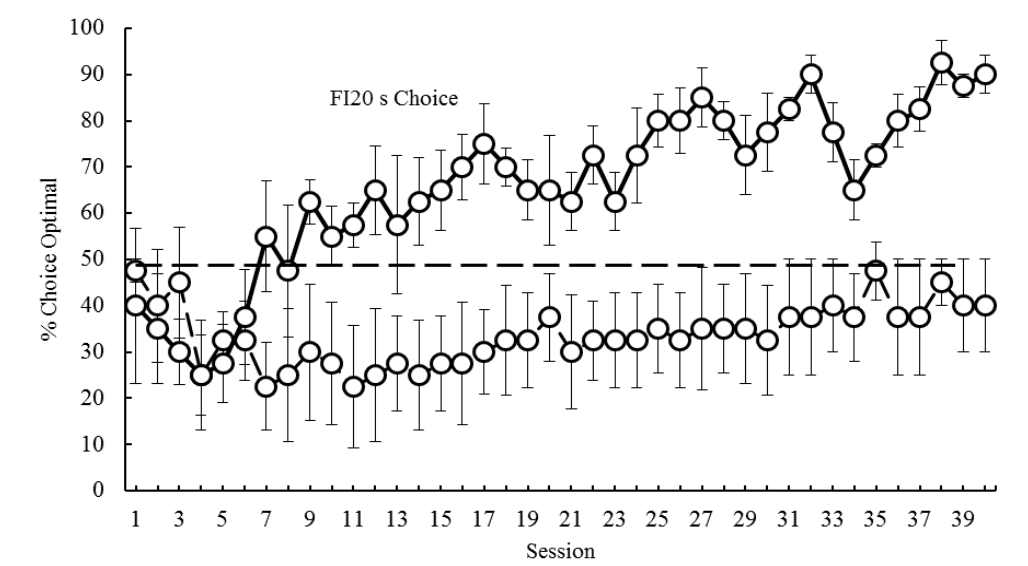
Figure 7 . Percentage optimal choice for pigeons that had to complete a fixed interval 20-s schedule (FI 20s Choice) to obtain initial reinforcement and pigeons that had to make a single peck to obtain initial reinforcement (error bars = ±SEM; after Zentall et al.,